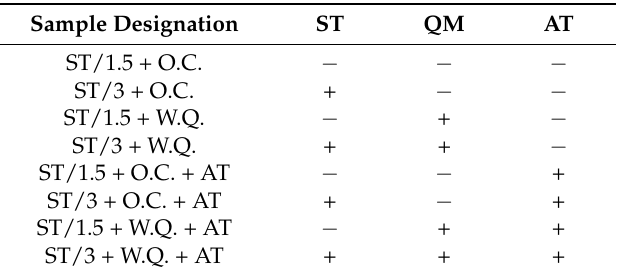
Table 3. Matrix of experiments.